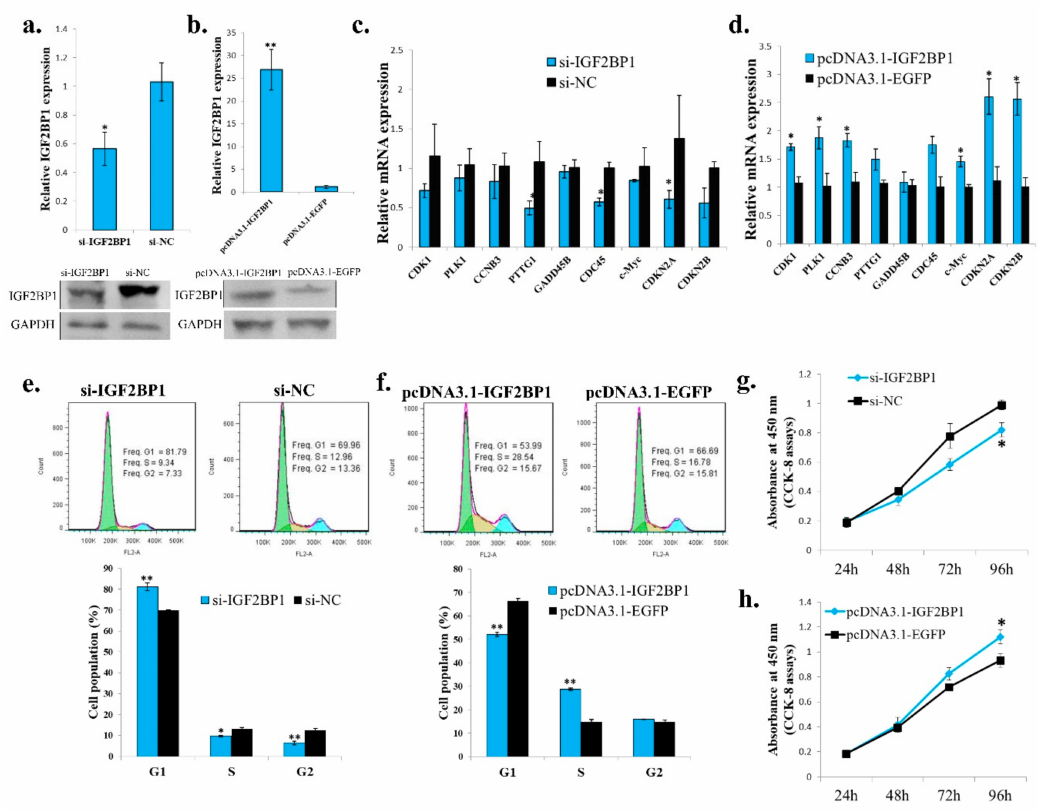
Figure 5. IGF2BP1 promotes chicken adipocyte proliferation. ( a ) The mRNA and protein expression of IGF2BP1 after 48 h transfection of si-IGF2BP1 in an ICP cell. ( b ) The mRNA and protein expression of IGF2BP1 after 48 h transfection of IGF2BP1 overexpression vector in an ICP cell. ( c ). The expression of cell cycle related genes after transfection of si-IGF2BP1 in an ICP cell. ( d ) The expression of cell cycle related genes after overexpression of IGF2BP1 in an ICP cell. ( e ) IGF2BP1 inhibition induced cell cycle arrest in an ICP cell. ( f ) IGF2BP1 overexpression promote cell cycle progress in an ICP cell. ( g ) IGF2BP1 inhibition repressed cell proliferation in an ICP cell. ( h ) IGF2BP1 overexpression promote cell proliferation in an ICP cell. The data are mean ± S.E.M. with at least 3 samples ( n ≥ 3 / treatment group). Independent sample t test was used to analyze the statistical di ff erences between groups. * p < 0.05; ** p <